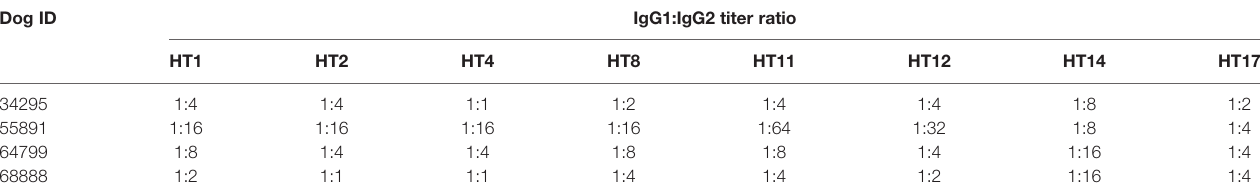
TABLE 4 | The IgG1:IgG2 ratios against each holocyclotoxin within the cocktail vaccination at 14 days post immunization in trial 2. Dog